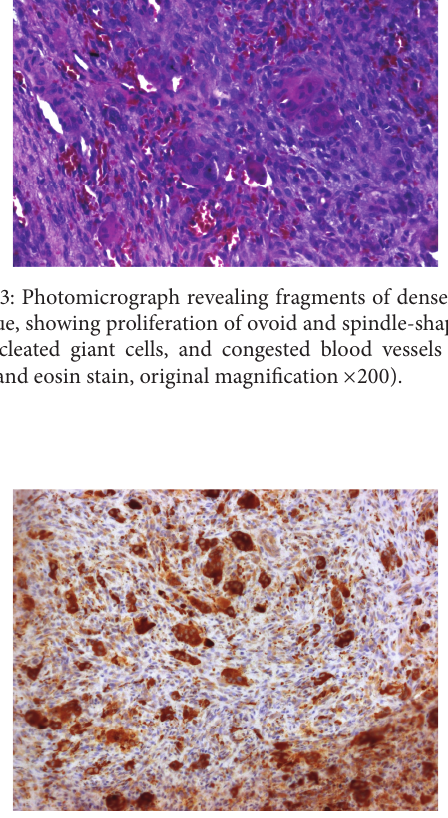
Figure 4: Immunohistochemical staining with CD68 showing strong positivity for multinucleated giant cells (original magnifica- tion ×